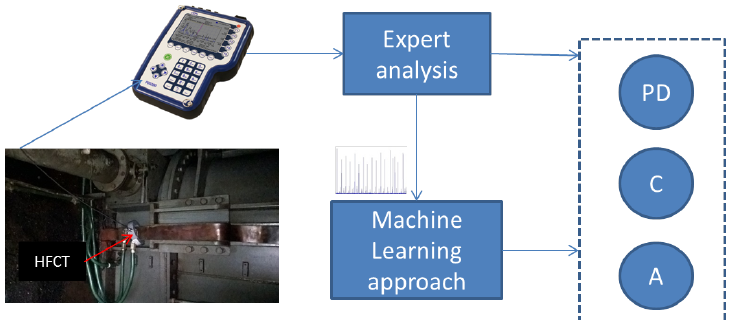
Figure 1. Electromagnetic Interference (EMI) data acquisition using High-Frequency Current Transformer (HFCT) and discharge type identification (e.g., Partial Discharge (PD), Corona (C), and Arcing (A) by EMI experts and their Machine Learning